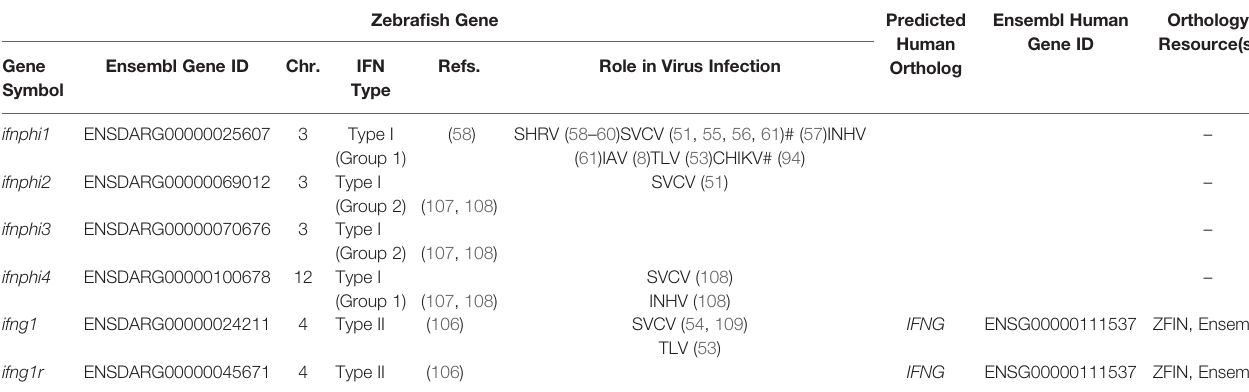
TABLE 4 | IFN genes in zebra fi